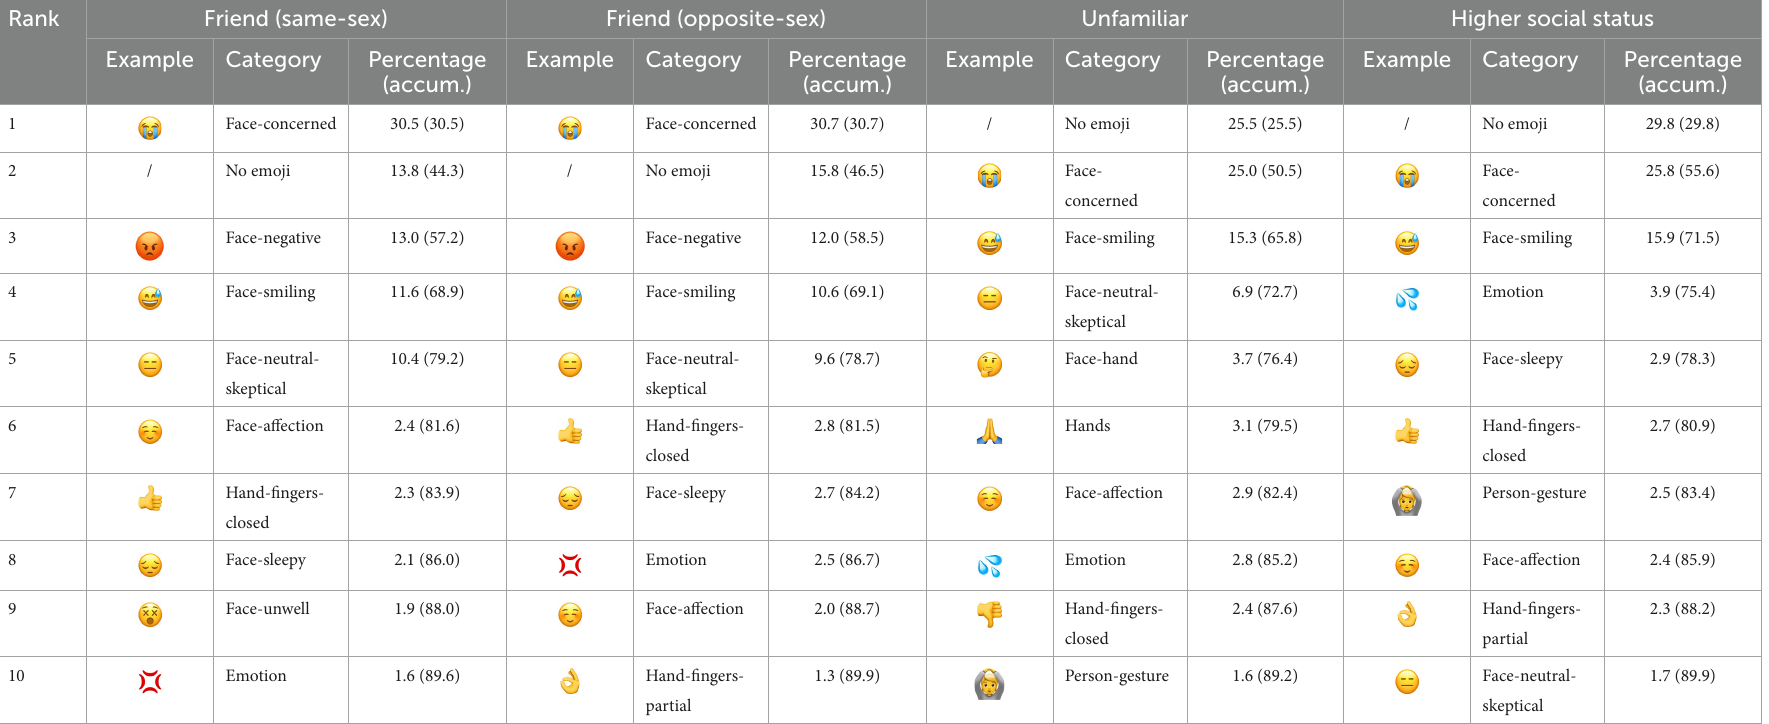
TABLE 4 Most used emoji categories with different targets (interactor broke a